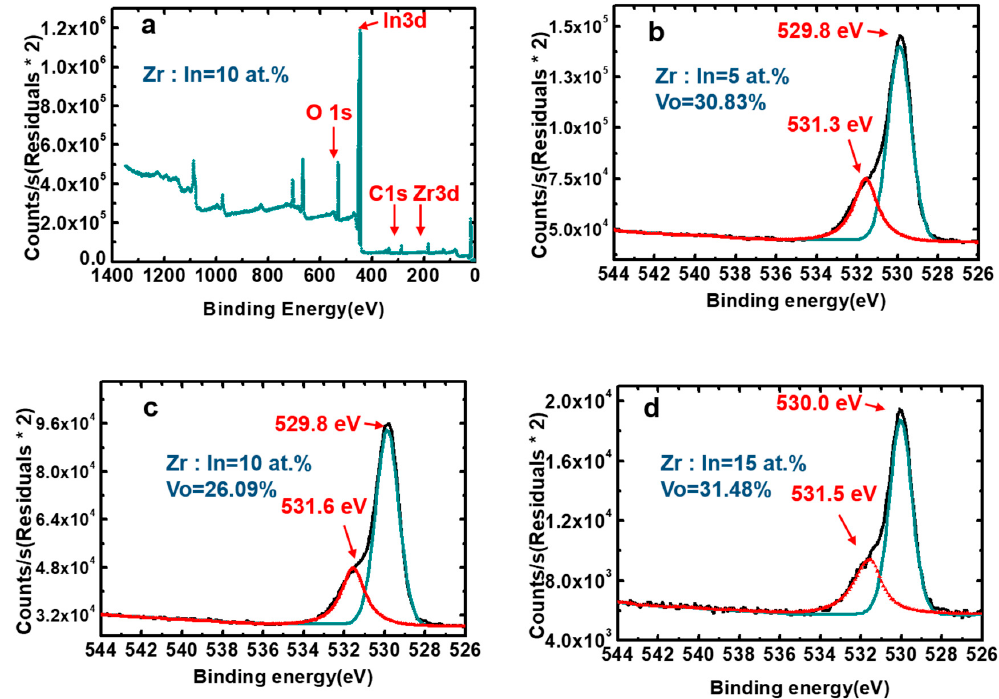
Figure 6. X-ray photon spectroscopy (XPS) spectra: ( a ) Overview scans of sample. ( b – d ) O 1 s for the solution-processed indium oxide thin films with different Zr doping concentrations (Zr:In = 5, 10, and 15 at.%). Table 2. The relative quantity of oxygen vacancies varied with the Zr doping concentrations. Zr Doping Concentration (at.%)